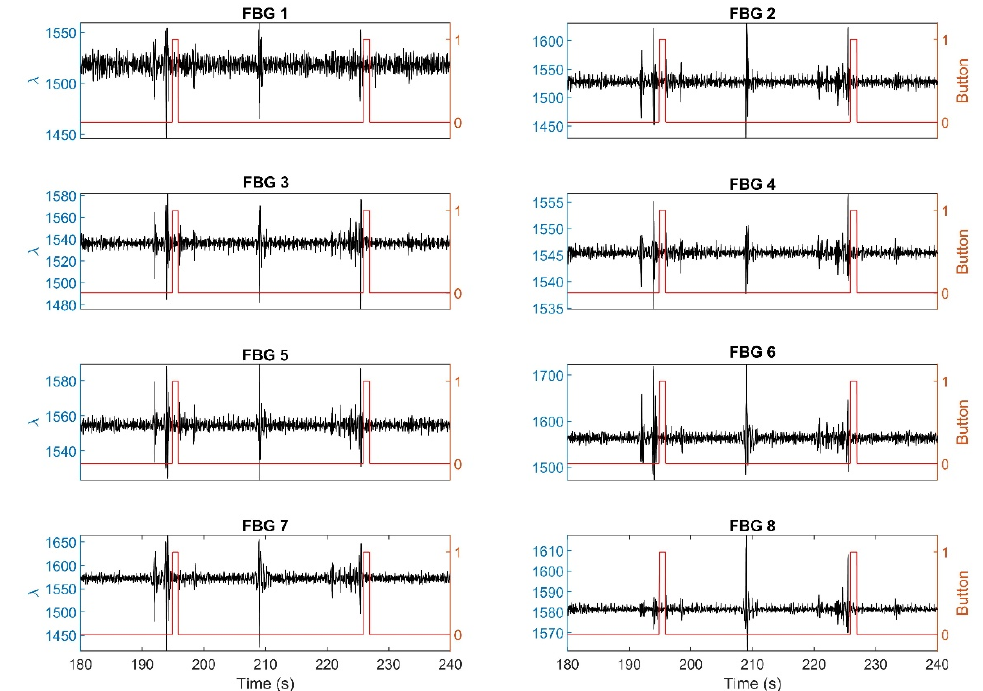
Figure 11. Independent component analysis of the raw sensing signals shown in Figure 10. The black line with the left y axis shows the response of the sensor. The red line with the right y axis shows the mother’s perception. Mother perceived two movements, while FBG sensors detected three movements.